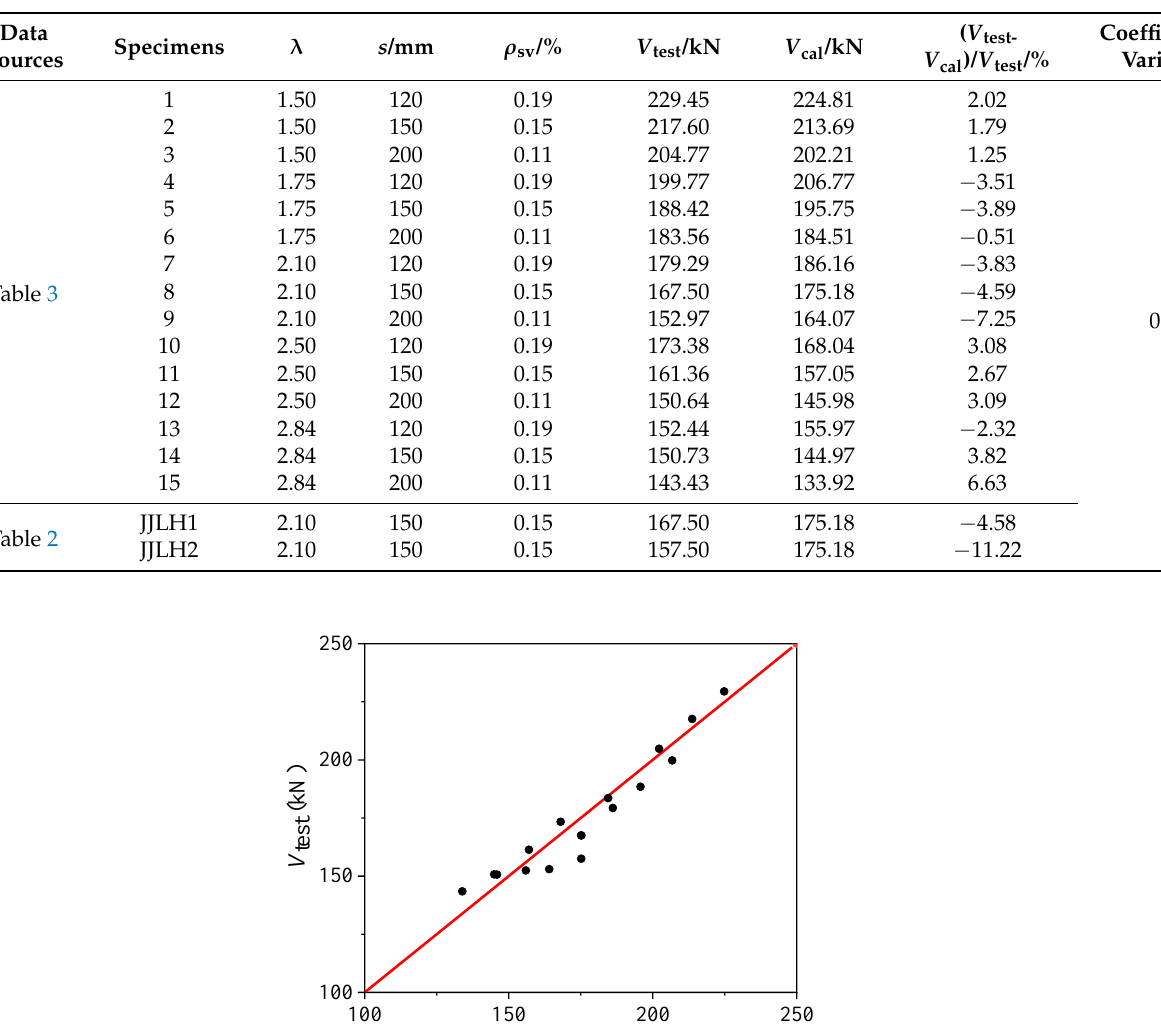
Table 4. Comparison of the failure load between V test and V cal .